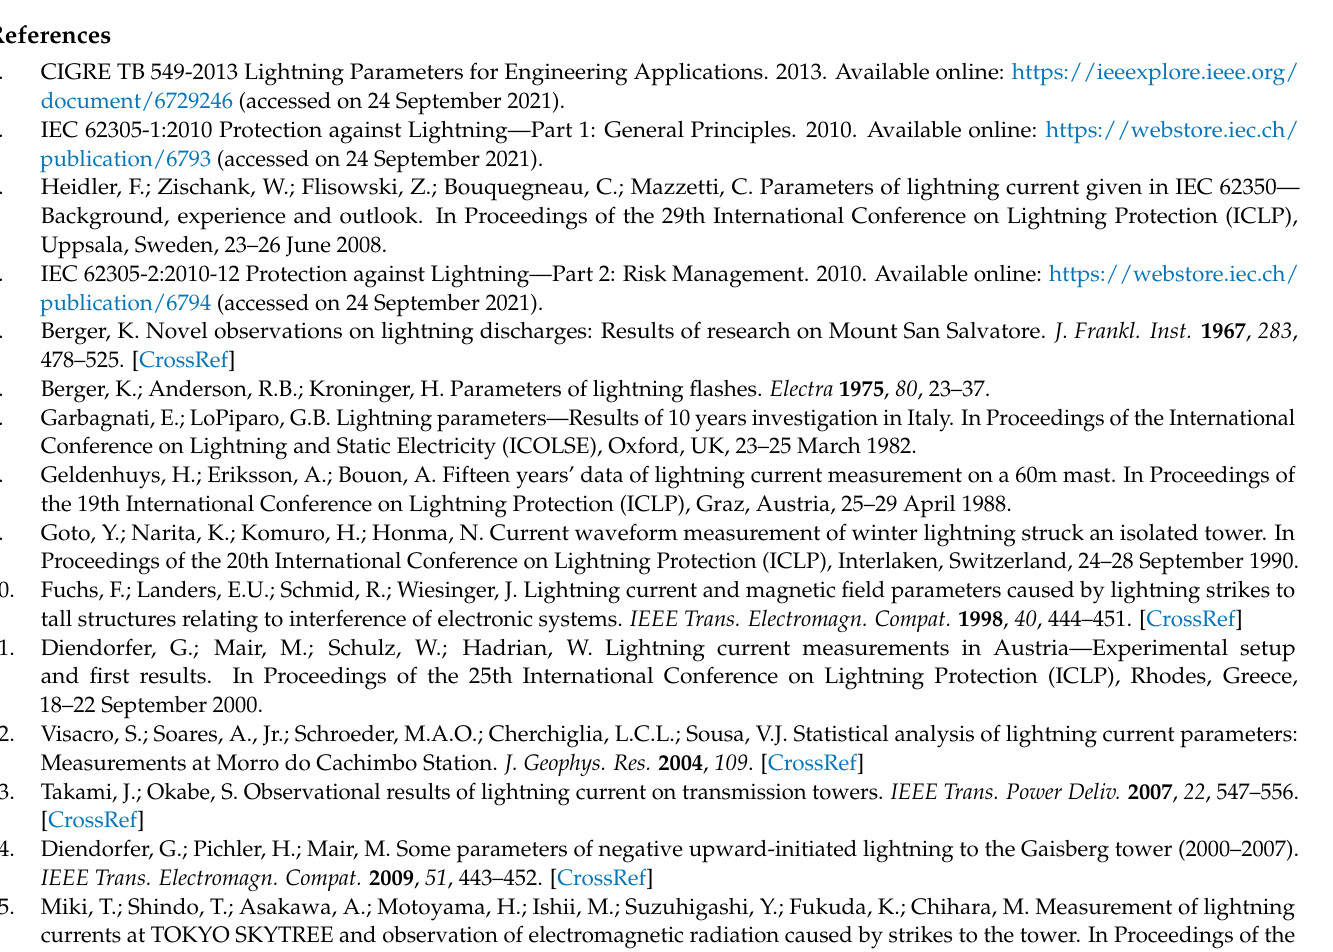
Figure A10. Lightning current amplitude probability distributions for positive and negative strikes extracted from the recorded incidents throughout the period 2011–2020 for WP10.